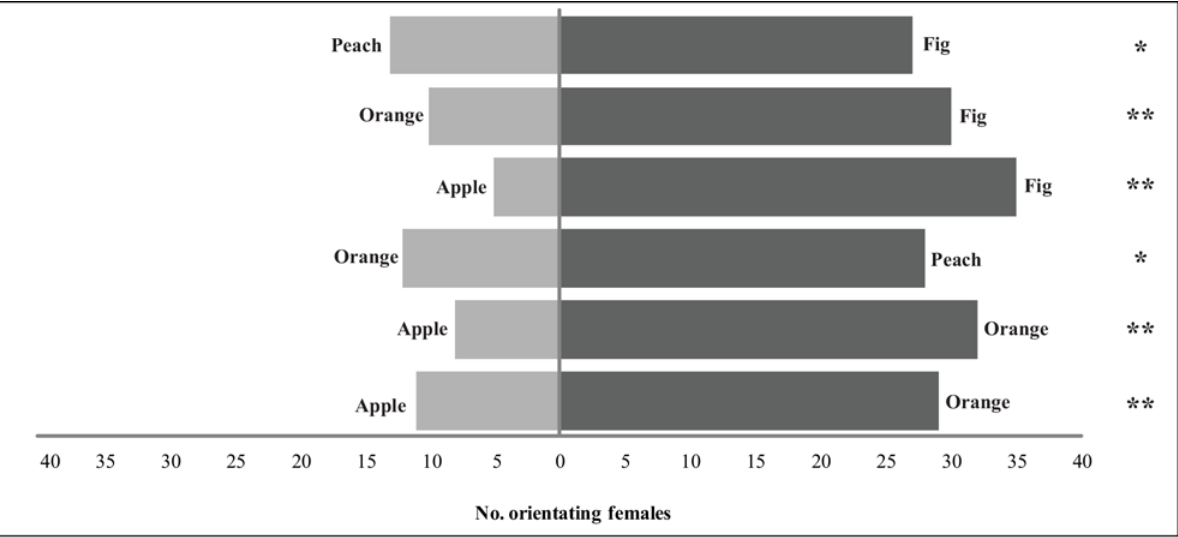
Fig 1. Preference for different fruit species by Diachasmimorpha longicaudata females in a Y-tube olfactometer. Bars show the number of females visiting each option in each pair-wise combination among the four fruit species (experiment 1). G-test level of significance: * p < 0.05; ** p < 0.01.